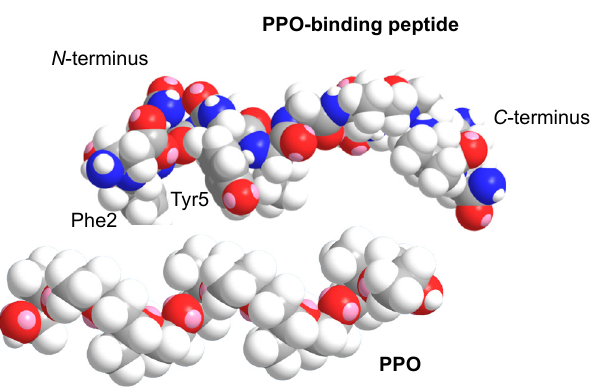
Figure 5. Structural comparison of PPO and PPO-binding peptides obtained from molecular mechanics (MM) calculations. Grey, white, blue, and red colors represent carbon, hydrogen, nitrogen, and oxygen molecules, respectively.